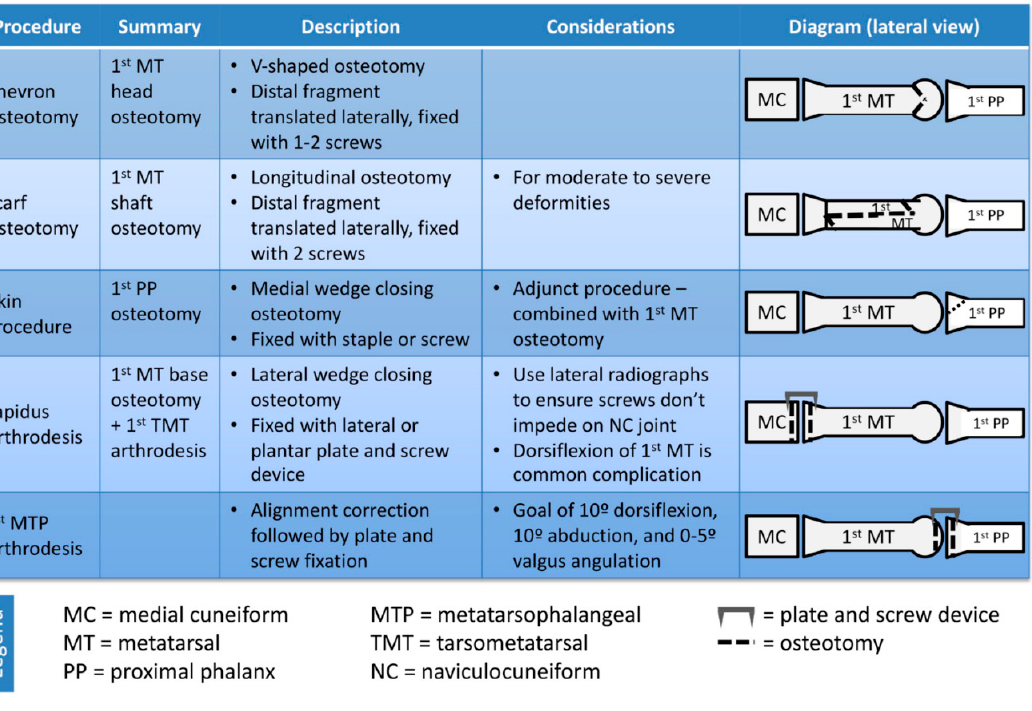
Figure 2. Surgical options for correction of hallux valgus.